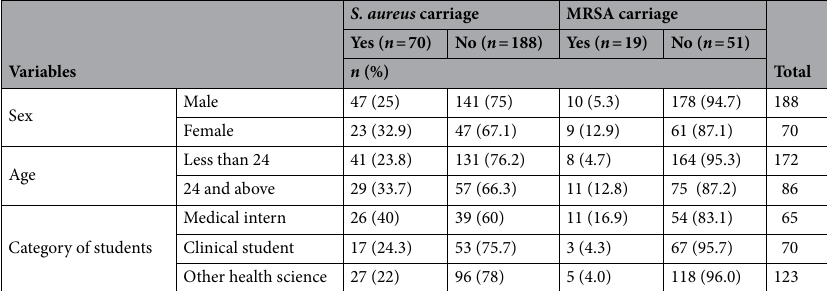
Table 2. Prevalence of S. aureus and MRSA among medicine and health science students of Arba Minch University, Arba Minch, southern Ethiopia, 2020.